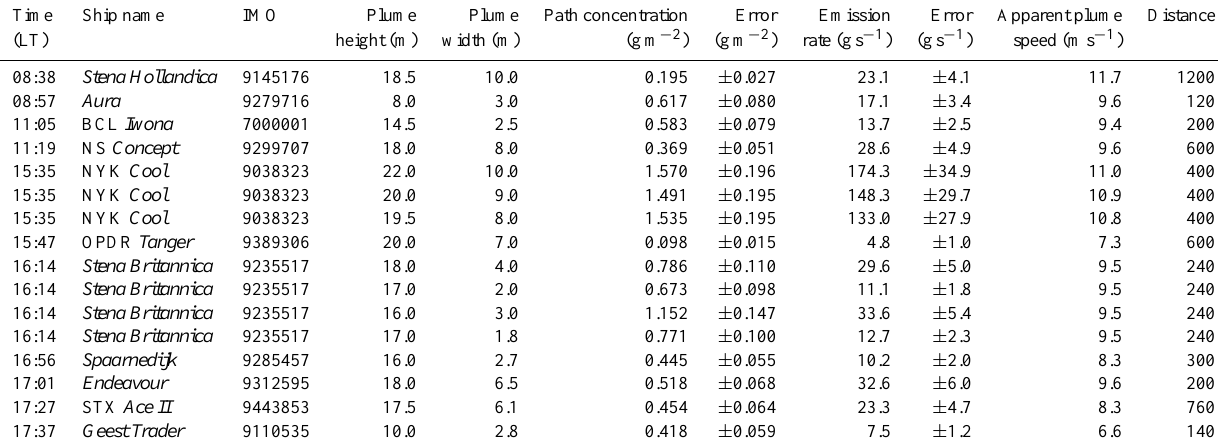
Table 4. SO 2 path amounts and emission estimates from the UV camera for measurements on 18 September